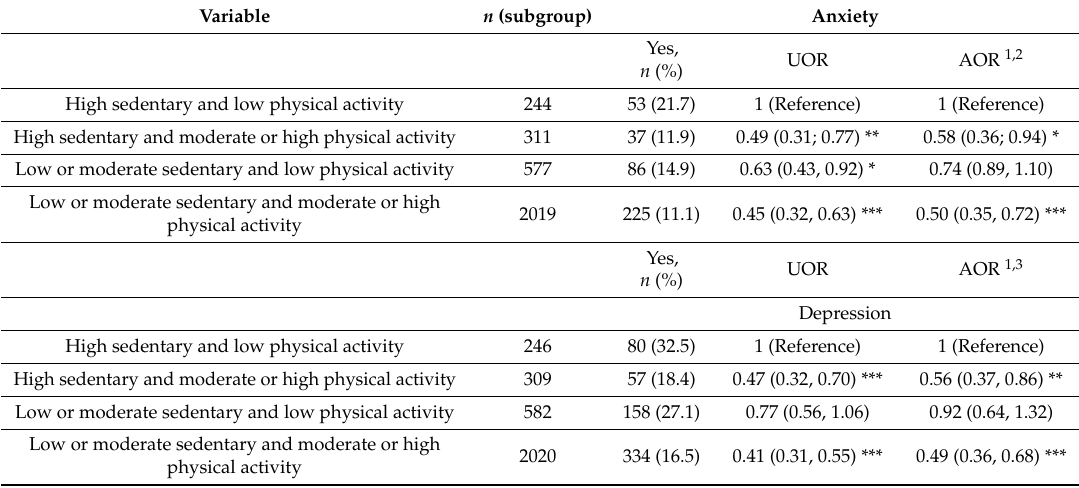
Table 3. Combined effects of sedentary behaviour and physical activity on anxiety and depression. Variable n